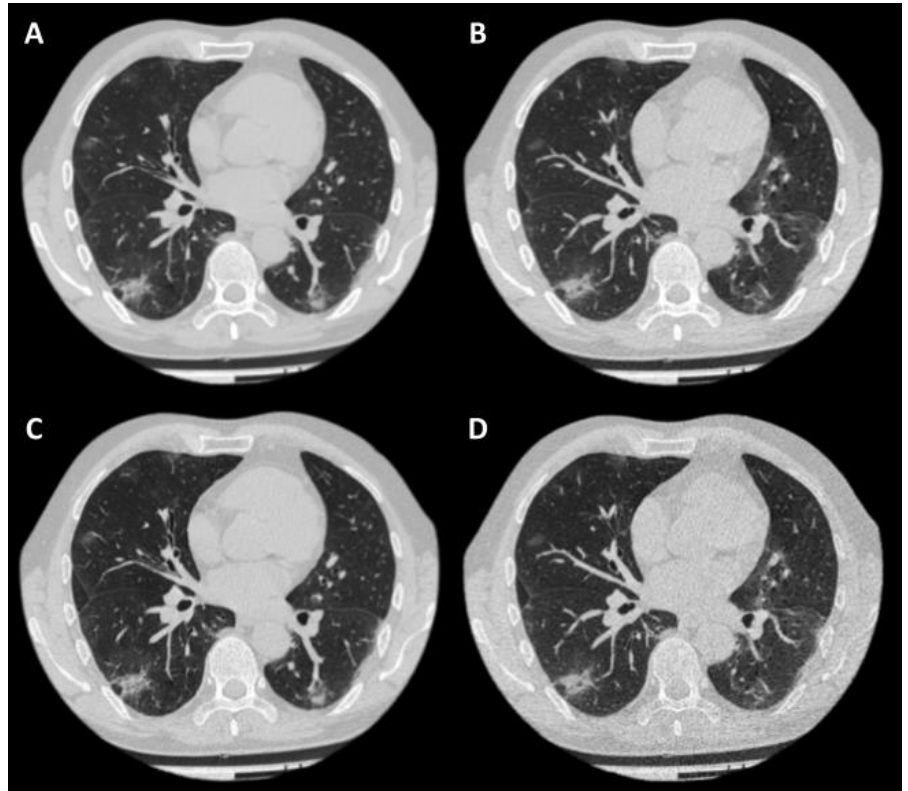
Figure 2. Example of a case in four reconstructions. Patient: 57-year-old male, BMI = 24.05 kg/m 2 ; ( A )—CT soft; ( B )—LDCT soft; ( C )—CT sharp; ( D )—LDCT sharp. CTDI vol for CT was 15.5 mGy, for LDCT — 3.4 mGy. The effective dose for standard CT was 10.31 mSv, for LDCT — 2.46 mSv. Table 1. Inter-observer agreement for matched patient data.